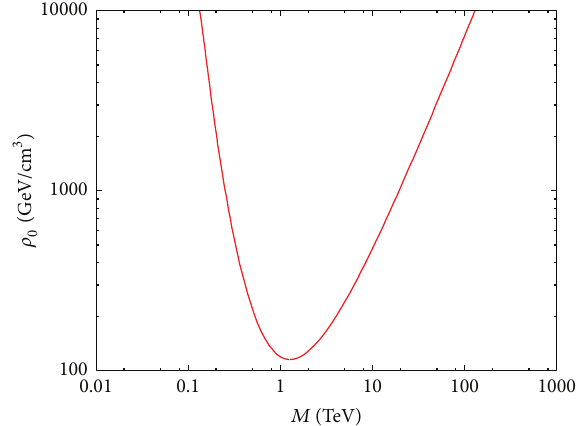
Figure 1: Values of the central dark-matter density 𝜌 0 (GeV/cm 3 ) and of the OHe mass 𝑀 (TeV) reproducing the excess of 𝑒 + 𝑒 − pairs production in the galactic bulge. Below the red curve, the predicted rate is too